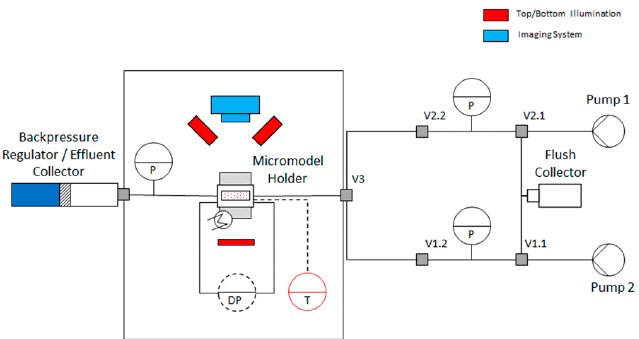
Figure 2. Schematic representation of the experimental setup used to perform micromodels experi- ments.